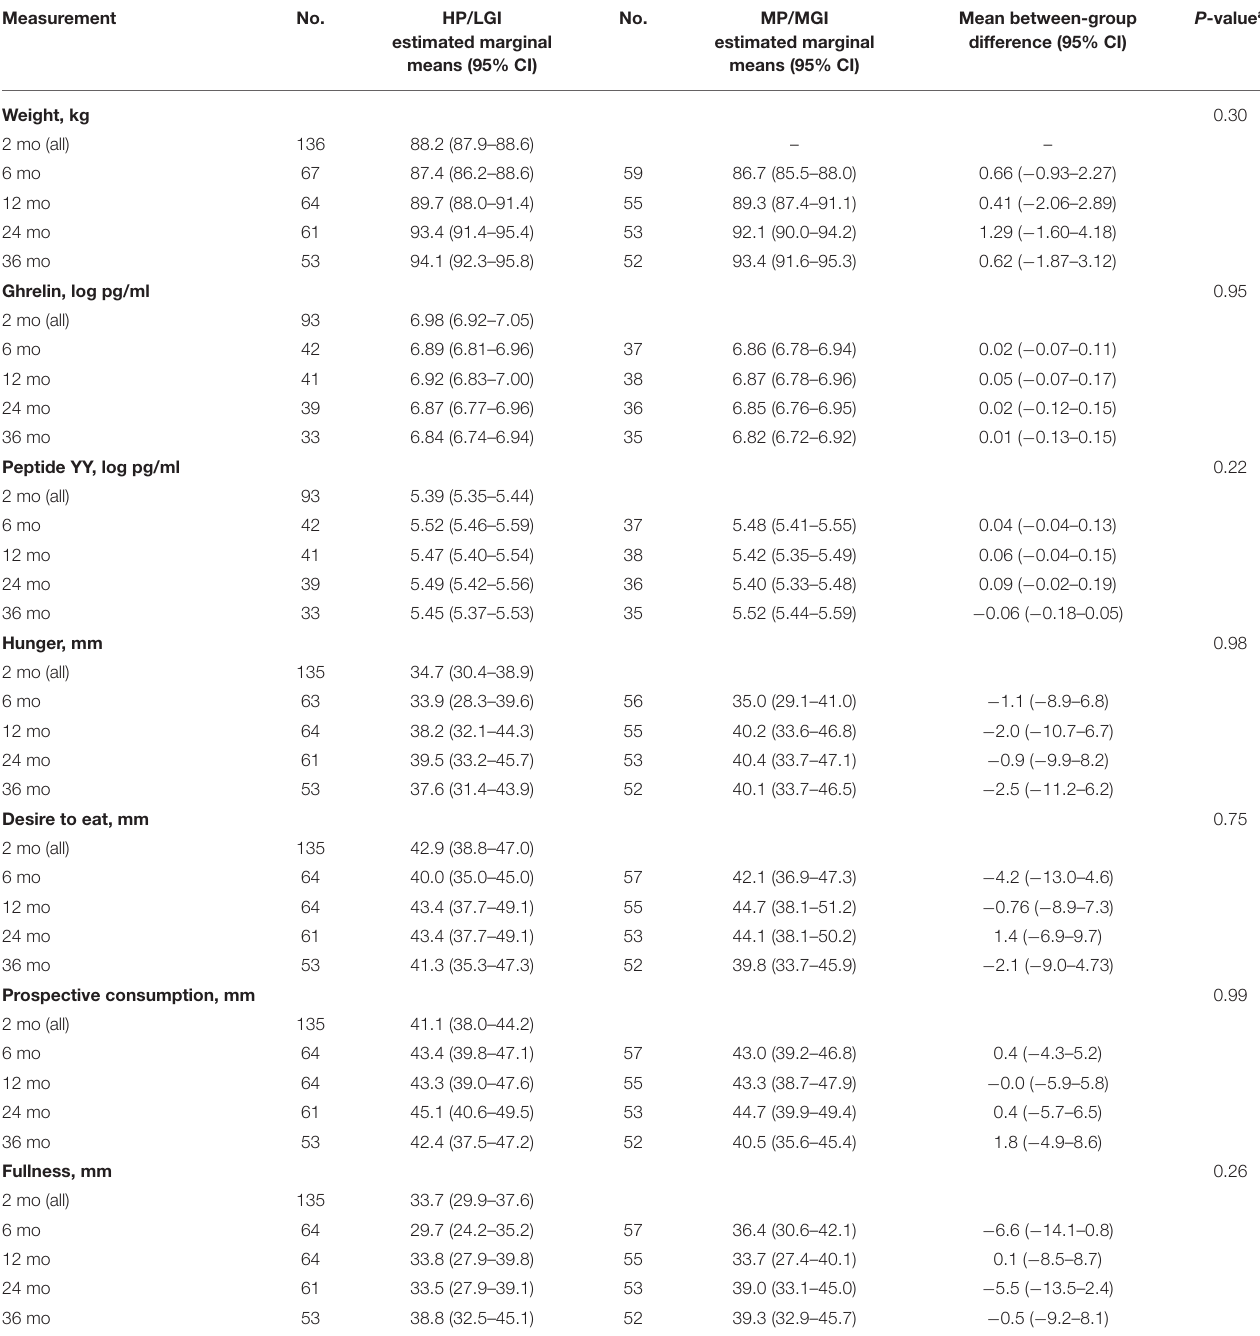
TABLE 2 | Body weight, plasma gut hormone concentrations, and fasting appetite sensations with the higher-protein/low-GI (HP/LGI) and moderate-protein/moderate-GI (MP/MGI) weight-maintenance diets.